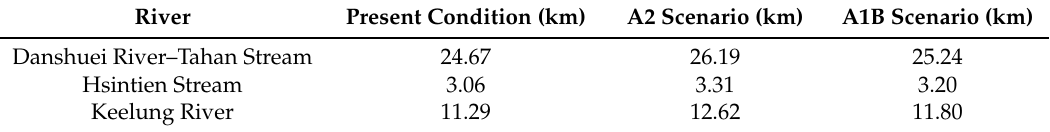
Table 8. The limit of salt water intrusion in the Danshuei River estuarine system under different